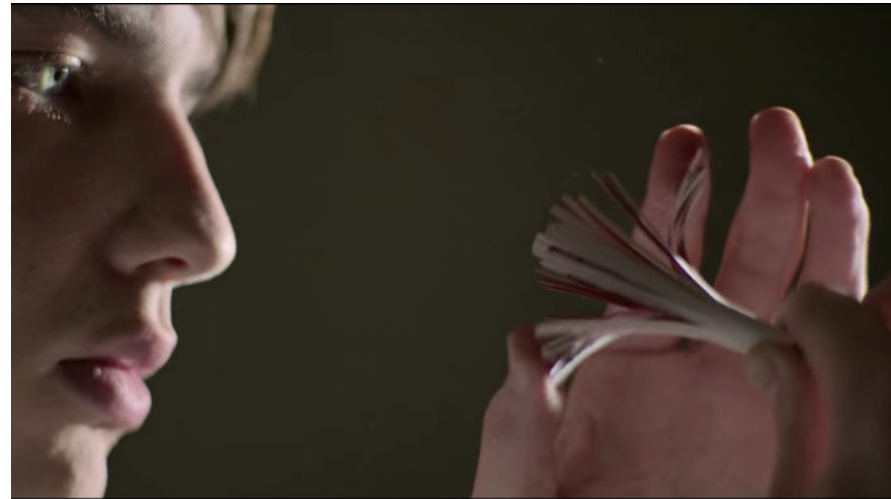
Figure 4. The Power of the Dog . Netflix.